Question: Summarize what this figure shows in one sentence.
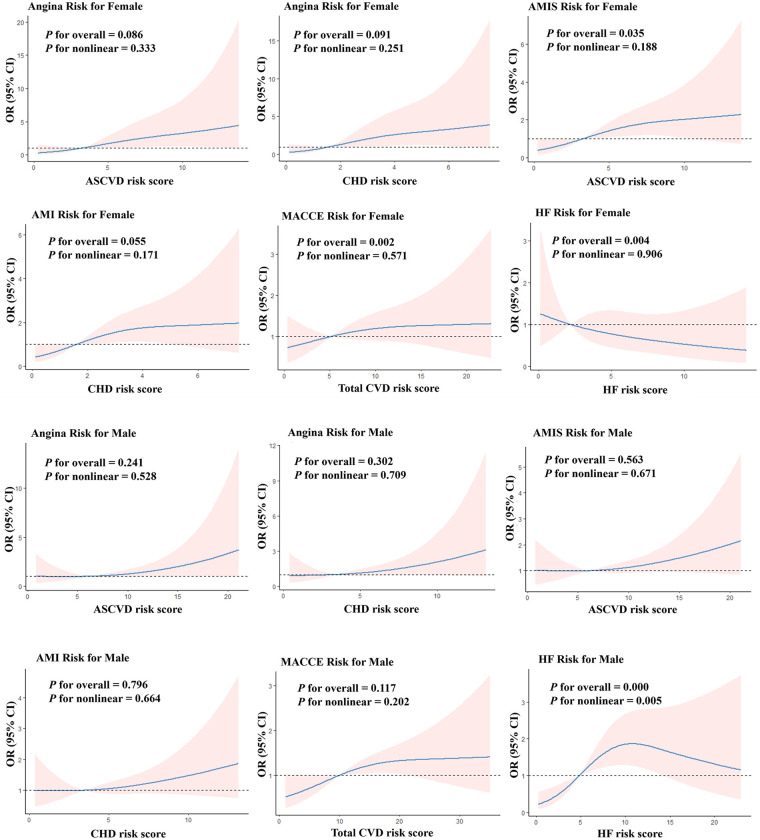
Answer: Restricted cubic spline curve for the association between PREVENT equations and major adverse cardiac and cerebral events. AMI, angina and myocardial injury; AMIS, angina, myocardial injury and stroke; ASCVD, atherosclerotic cardiovascular disease; CHD, coronary heart disease; CVD, cardiovascular disease; HF, heart failure; MACCE, major adverse cardiac and cerebral events, including angina, myocardial injury, stroke, or heart failure.